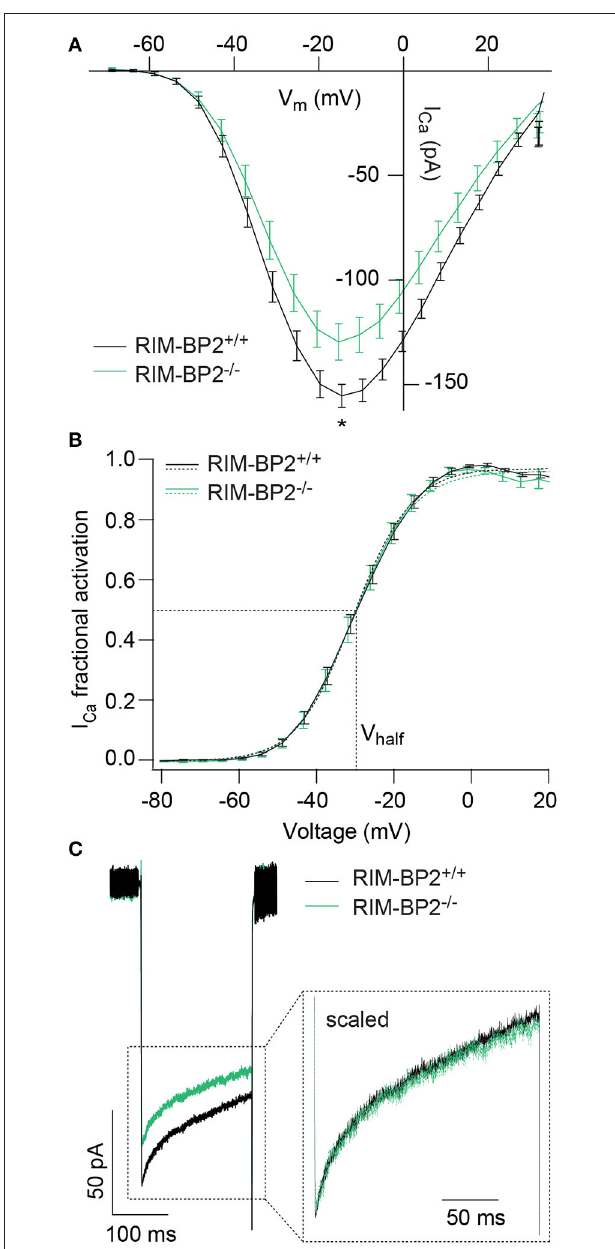
FIGURE 3 | RIM-BP2 promotes voltage-dependent Ca 2 + -influx in IHCs. (A) Ca 2 + current-voltage relationship of RIM-BP2-deficient ( RIM-BP2 − / − , n = 16, green) and control ( RIM-BP2 + / + , n = 17, black) IHCs. Current-voltage relationships (IVs) were calculated from the last 8ms of currents evoked by step depolarizations to various potentials. Ca 2 + -current amplitude was significantly reduced in RIM-BP2-deficient IHCs. (B) Fractional activation curves of the whole-cell Ca 2 + -current: A Boltzmann function was fit to the normalized conductance curve (B) calculated from the Ca 2 + -current-voltage relationship (A) . Average fit data (dashed traces) are displayed for both genotypes ( RIM-BP2 − / − , n = 16, green and RIM-BP2 + / + , n = 17, black). Dashed lines indicate V half and the slope k, reporting the voltage of half-maximal activation of the whole-cell Ca 2 + -current and thevoltage-sensitivityofCa 2 + -influx. (C) Ca 2 + -current,I Ca